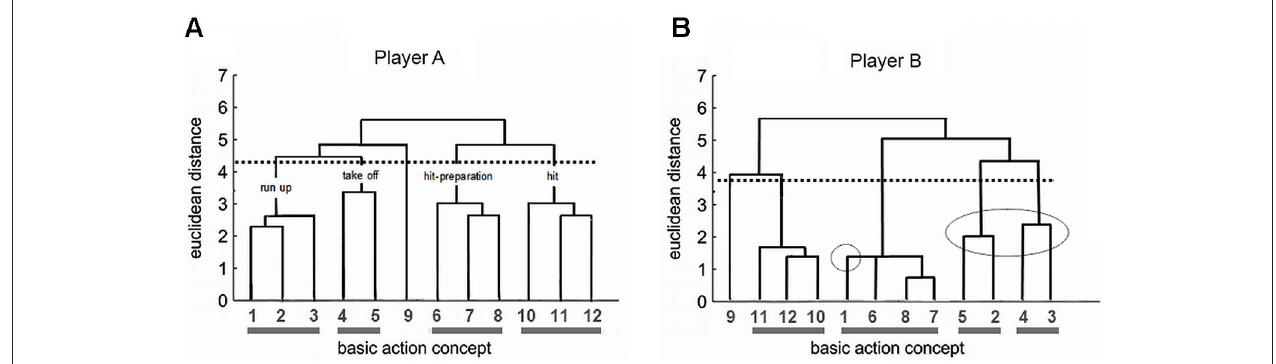
(12) drawthrough of hitting arm. A scale indicating the distances of BAC representations in movement memory is located on the left side of the figure. The lower the value of a horizontal connection between two BACs, the lower the distance between them in movement memory (Printed from: Schack, 2004a, p. 417 with